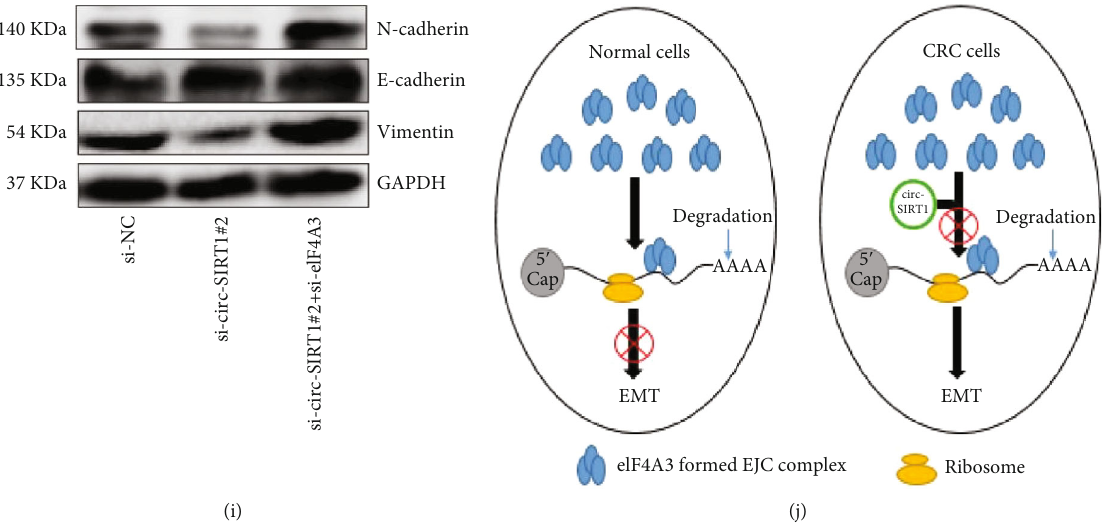
Figure 5: circ-SIRT1 promotes EMT by binding to eIF4A3. RIP and RNA pull-down assays demonstrated the binding of circ-SIRT1 to eIF4A3 (a) and (b). The expression of EIF4A3 was not regulated by cirC-SIRT1 (c). The expression of circ-SIRT1 after transfecting HCT116 cells with overexpression vector (d). Anti-IgG antibody was used as a negative control. After overexpression of circ-SIRT1, enrichment of EMT-related proteins mRNA in immunoprecipitation of anti-EIF4A3 RNA (e) and (f). Downregulation of EIF4A3 expression promotes the expression of EMT-related proteins N-cadherin and vimentin (g) and (h). Knockdown of EIF4A3 can reverse the inhibitory e ff ect of circ-SIRT1 on EMT (i). Schematic diagram of circ-SIRT1 combined with eIF4A3 to regulate the proliferation of colorectal cancer cells (j). ∗ stands for P < 0 : 05 , ∗∗ stands for P < 0 : 01